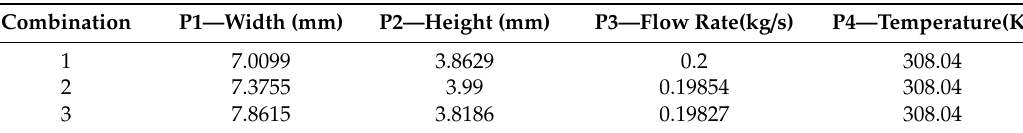
Table 6. Optimal combination of cooling channel dimensions.